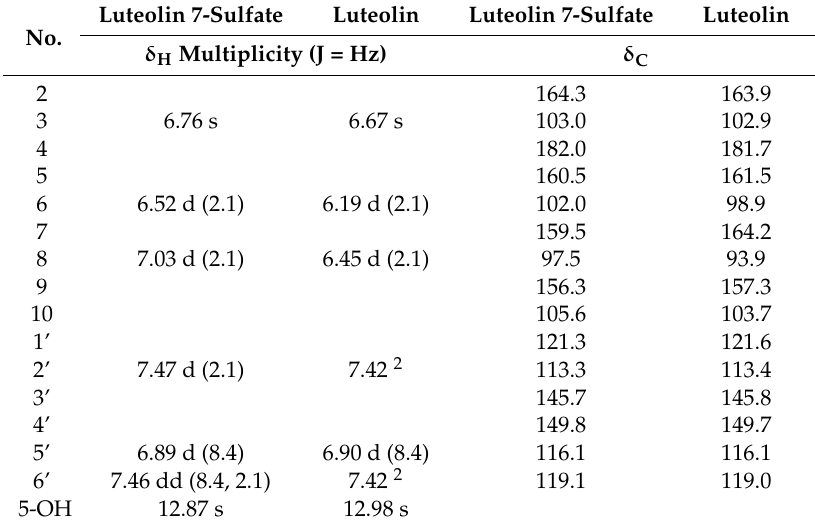
Table 1. Nuclear magnetic resonance (NMR) data of luteolin 7-sulfate and luteolin 1 . Luteolin 7-Sulfate Luteolin Luteolin 7-Sulfate Luteolin No. δ H Multiplicity (J = Hz)